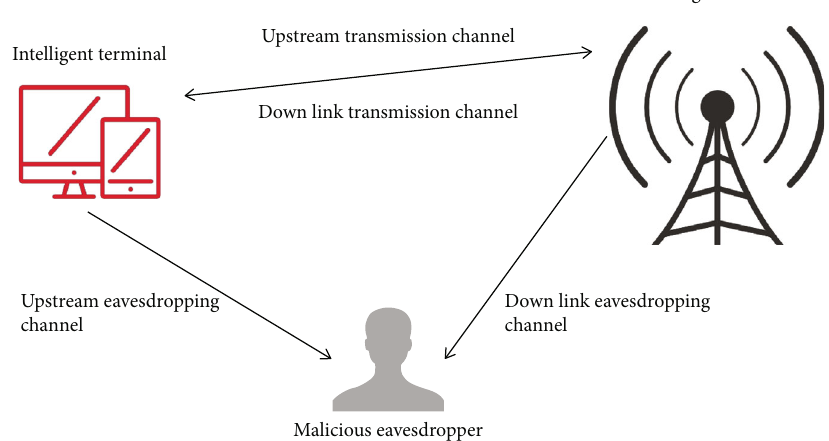
Figure 1: Downlink transmission system